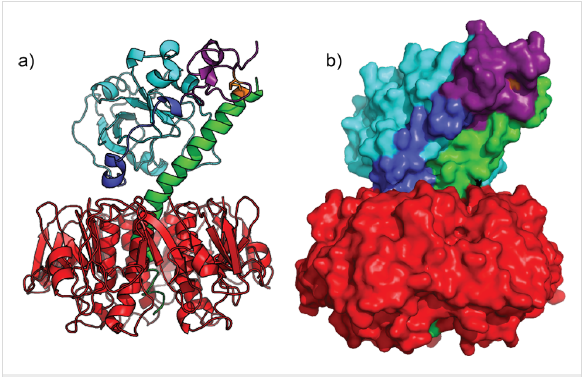
Figure 1: a) Ribbon and b) surface depictions of the cholera toxin: A1 1 domain in light blue; A1 2 domain in dark blue; A1 3 domain in purple; cystine disulfide in orange; A2 peptide in green and B-subunit in red. Figure prepared using the PyMOL programme from Protein Data Bank file